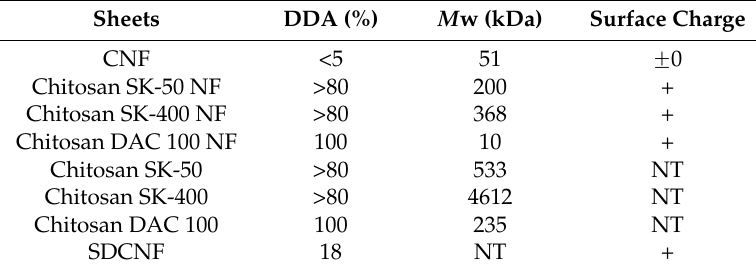
Table 1. Properties of chitosan materials.